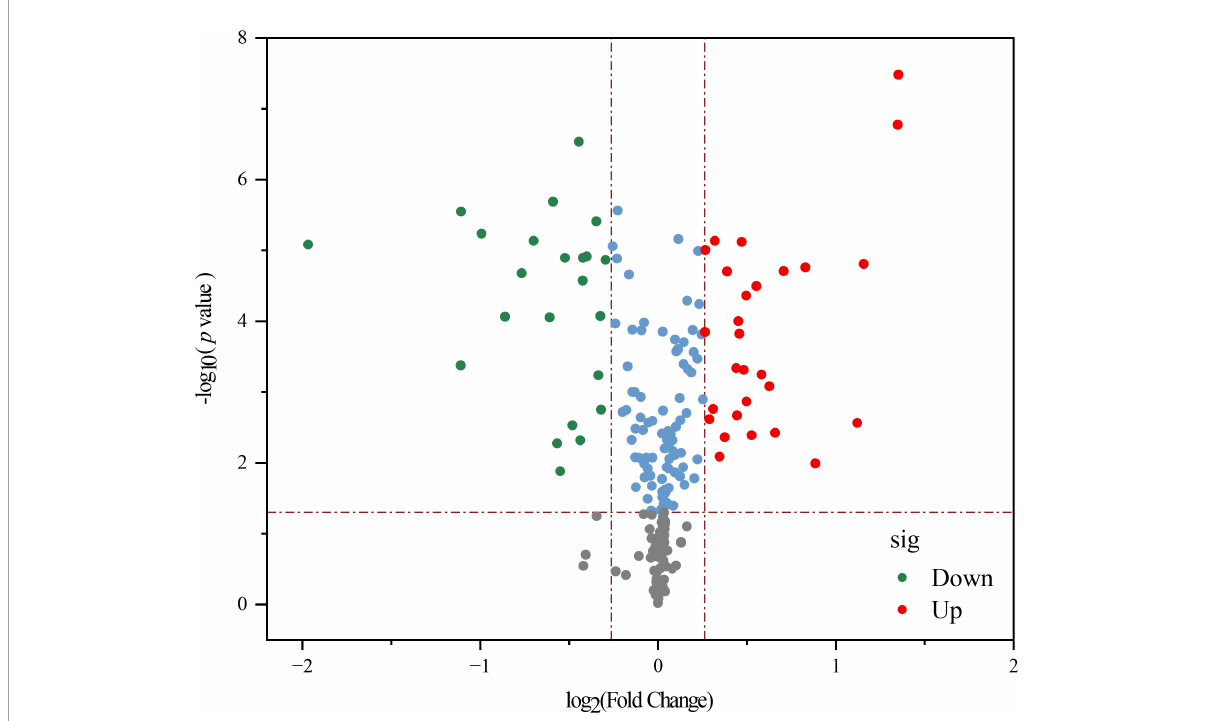
FIGURE4 A volcano plot showing differential non-volatile metabolites between RJ and Lactobacillus plantarum fermented juice (LPFJ). Red and green indicate up-and down-regulated